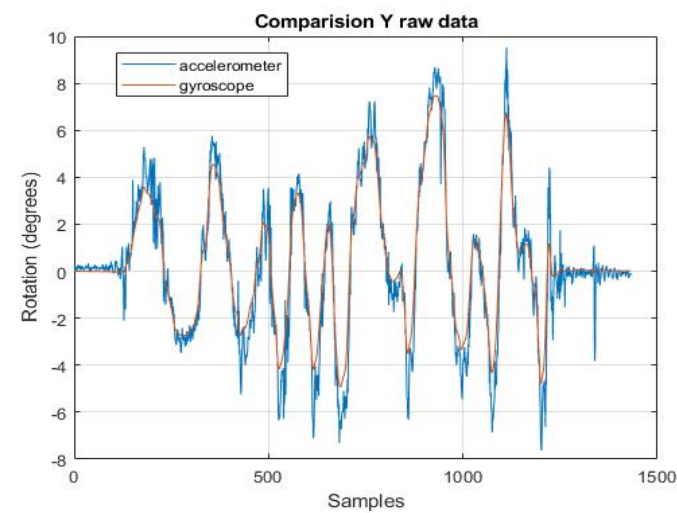
Figure 10. Y-axis rotation readings from accelerometer and gyroscope.